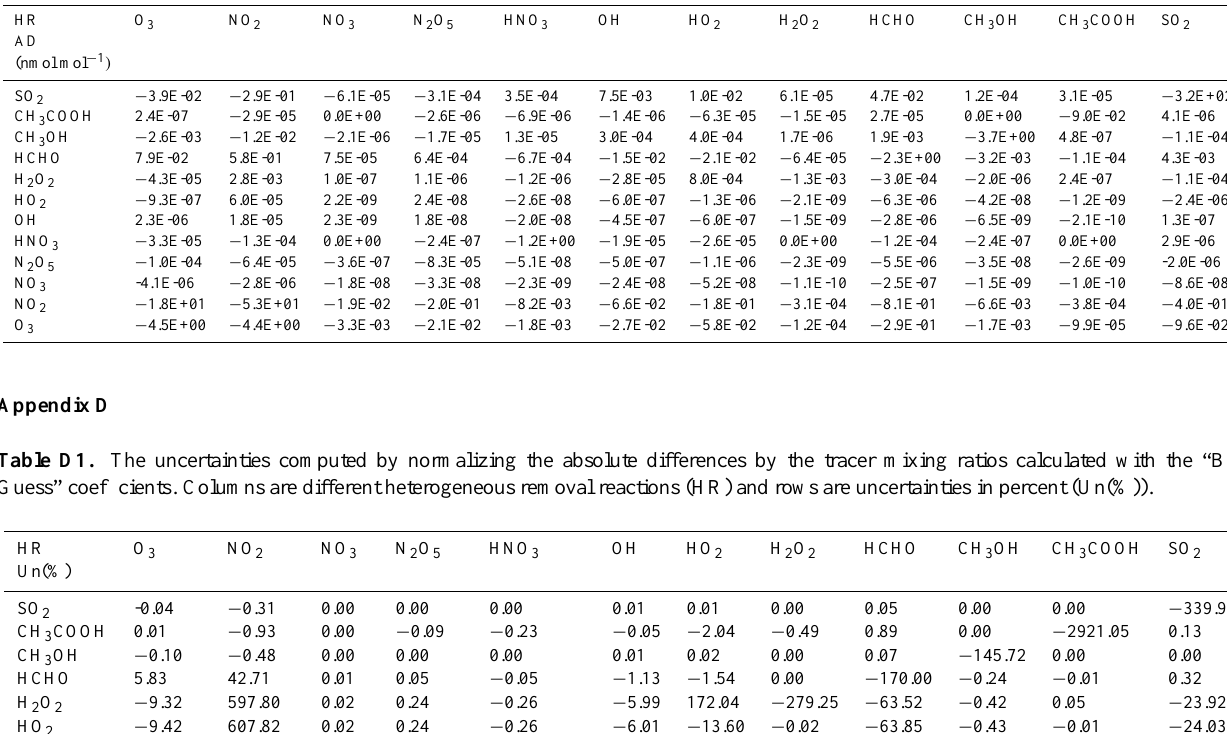
Table C1. The absolute differences in the tracer mixing ratios calculated with the “Upper Limit” and “Lower Limit” coefficients ( y DUST H (γ Upper ) − y DUST H (γ Lower ) ). Columns are different heterogeneous removal reactions (HR) and rows are absolute differences in ppbv (AD(nmol mol − 1 )).